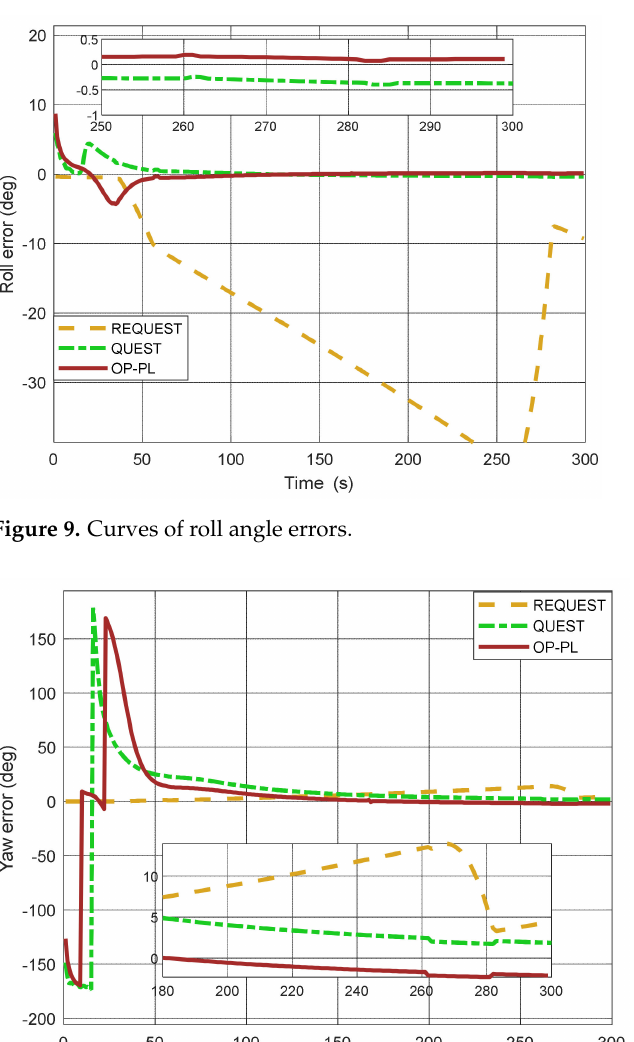
Figure 8. Curves of pitch angle errors.